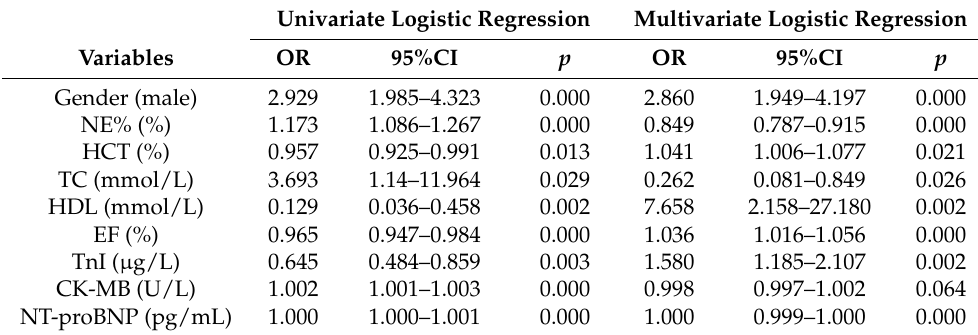
Table 6. Univariate and multivariate logistic regression analyzes for CTO predictors.